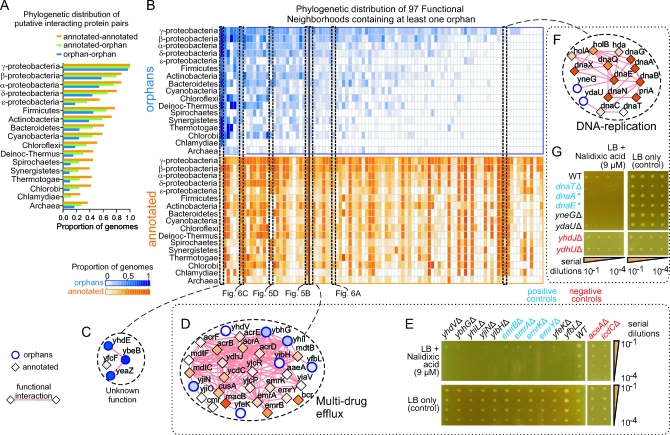
Evolutionary Conservation of Orphan Protein Function(A) Evolutionary conservation of orphan and annotated E. coli protein interaction partners in the integrated PI-GC network based on the co-occurrence of putative orthologs across fully sequenced prokaryotic genomes.(B) Phylogenetic distribution of the components of 97 functional neighborhoods with at least one orphan; the proportion of genomes showing conservation is indicated.(C) Atypical neighborhood illustrating broader conservation of orphans than annotated components; node shading reflects average phylogenetic conservation.(D) Representative neighborhood involved in drug efflux exhibiting similar phylogenetic distributions among its orphan and annotated components; analogous neighborhoods shown in preceding figures are indicated below [B].(E) Serial-dilution assay showing the drug hypersensitivity of deletion mutants of the orphans listed in [D].(F) DNA-replication neighborhood exhibiting a tendency of annotated components to be more widely distributed than the orphans.(G) Serial-dilution assay showing the perturbed growth of strains deleted for the two orphan components shown in [F] in the presence of an antibiotic inhibitor of DNA-replication; an asterisk (*) indicates hypomorphic alleles. Mutants deleted of relevant annotated proteins are shown as positive controls, while mutants lacking genes not contained within this neighborhood are shown as negative controls. LB, Luria Bertani medium.